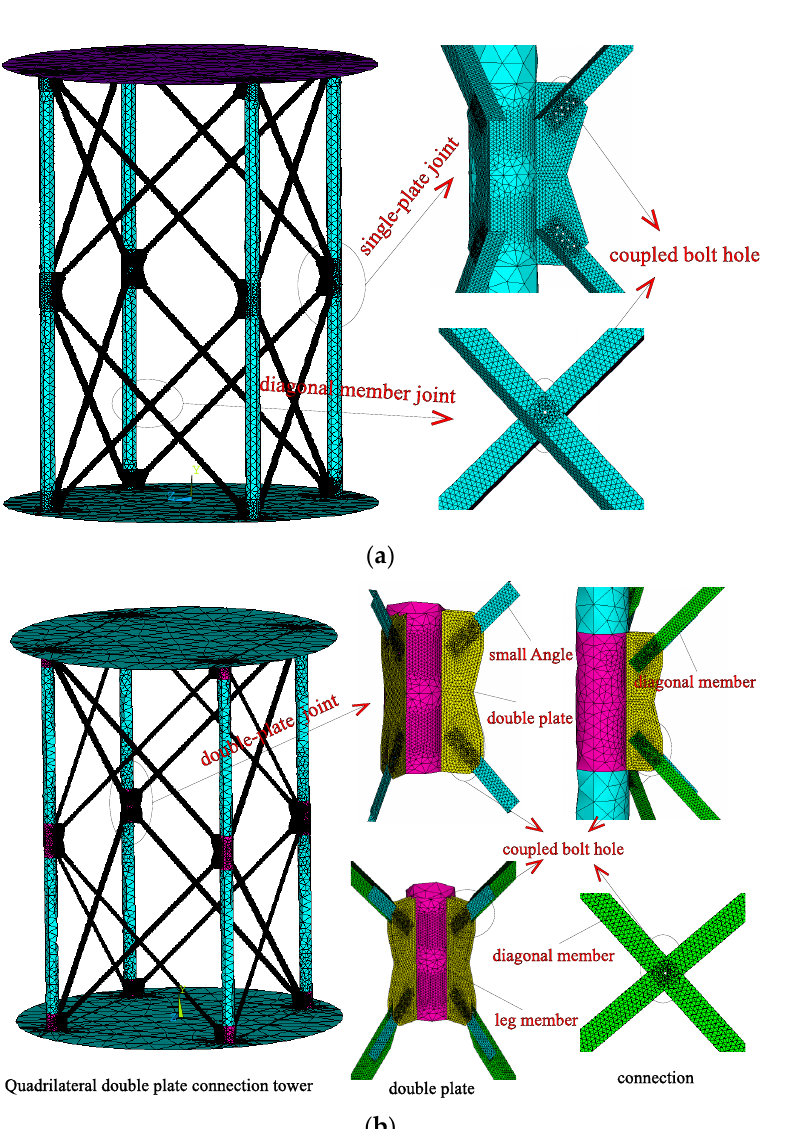
Figure 16. ( a ) Finite element model of quadrilateral tower with SLSPJ; ( b ) finite element model of quadrilateral tower with DLDPJ.